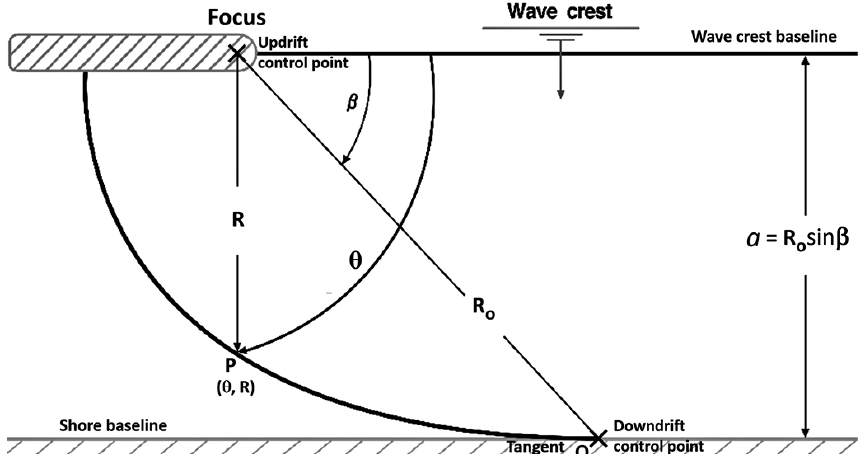
Figure 4. Definition sketch of parabolic bay shape model proposed by Hsu and Evans (1989).